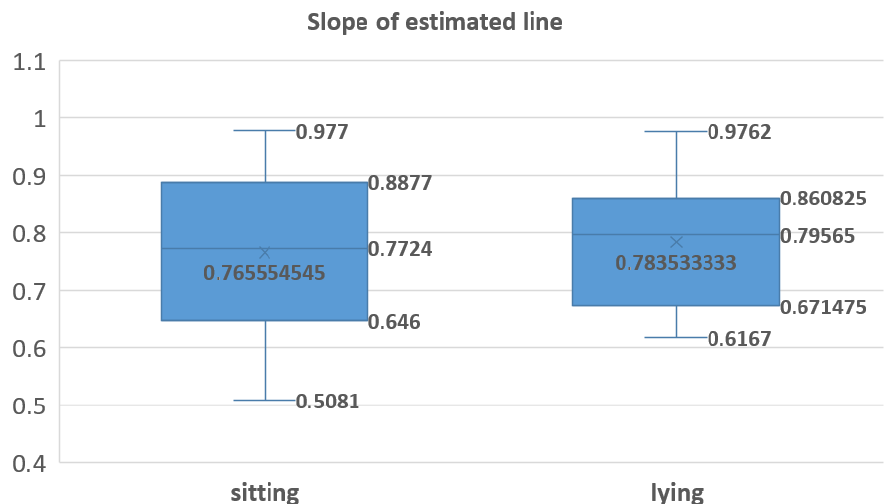
Figure 20. Box plot (like box plot of Figure 12) for the evaluation of the results of PDR according to EDR, separated in sitting ( left ) and lying ( right )